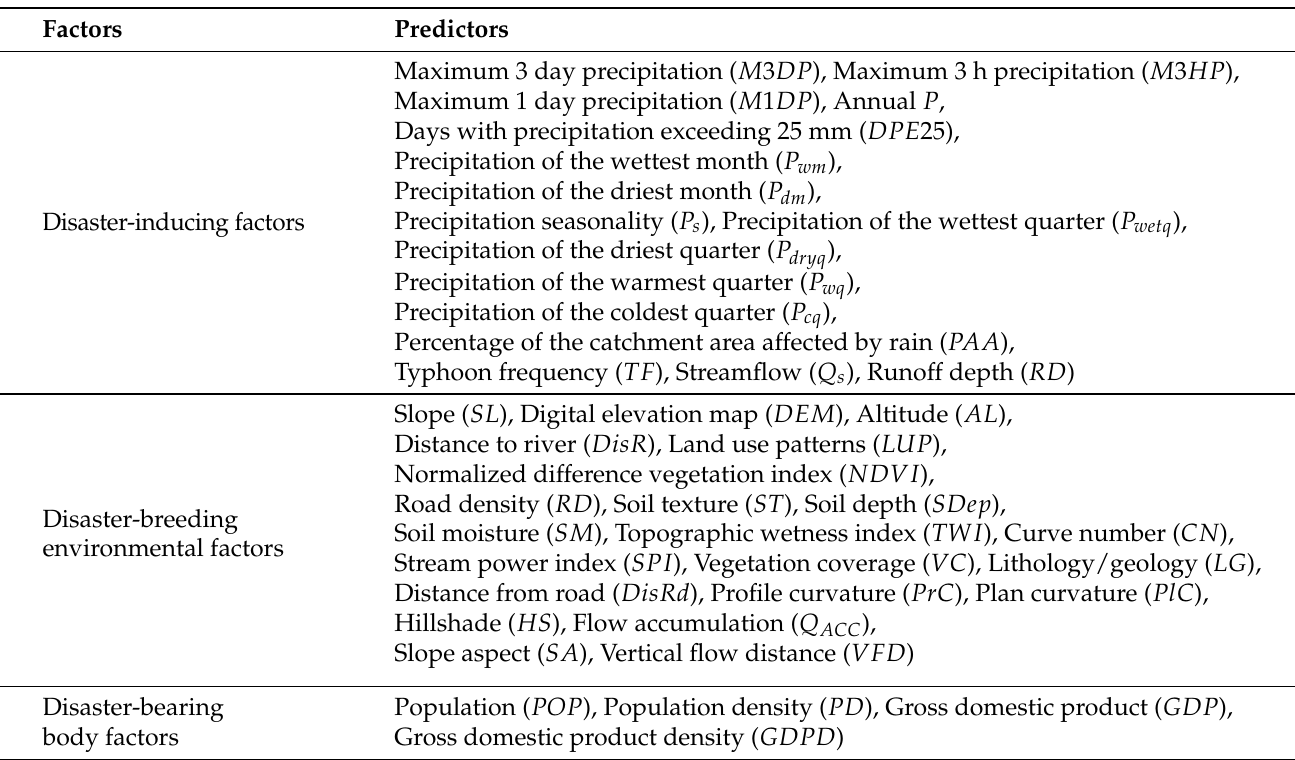
Table 7. Factors and predictors used in IAI-based flood hazard risk